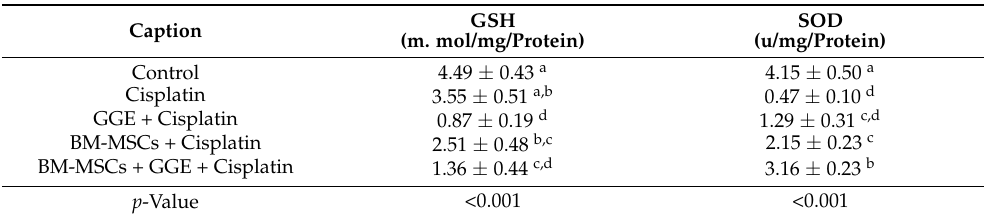
Table 2. The effect of the treatment groups (Control, Cisplatin, Cisplatin + GGE, Cisplatin + BM-MSCs, and Cisplatin + BM-MSCs + GGE) on the SOD and GSH level in rats. Different alphabetic letter/s being significantly different ( p < 0.05).